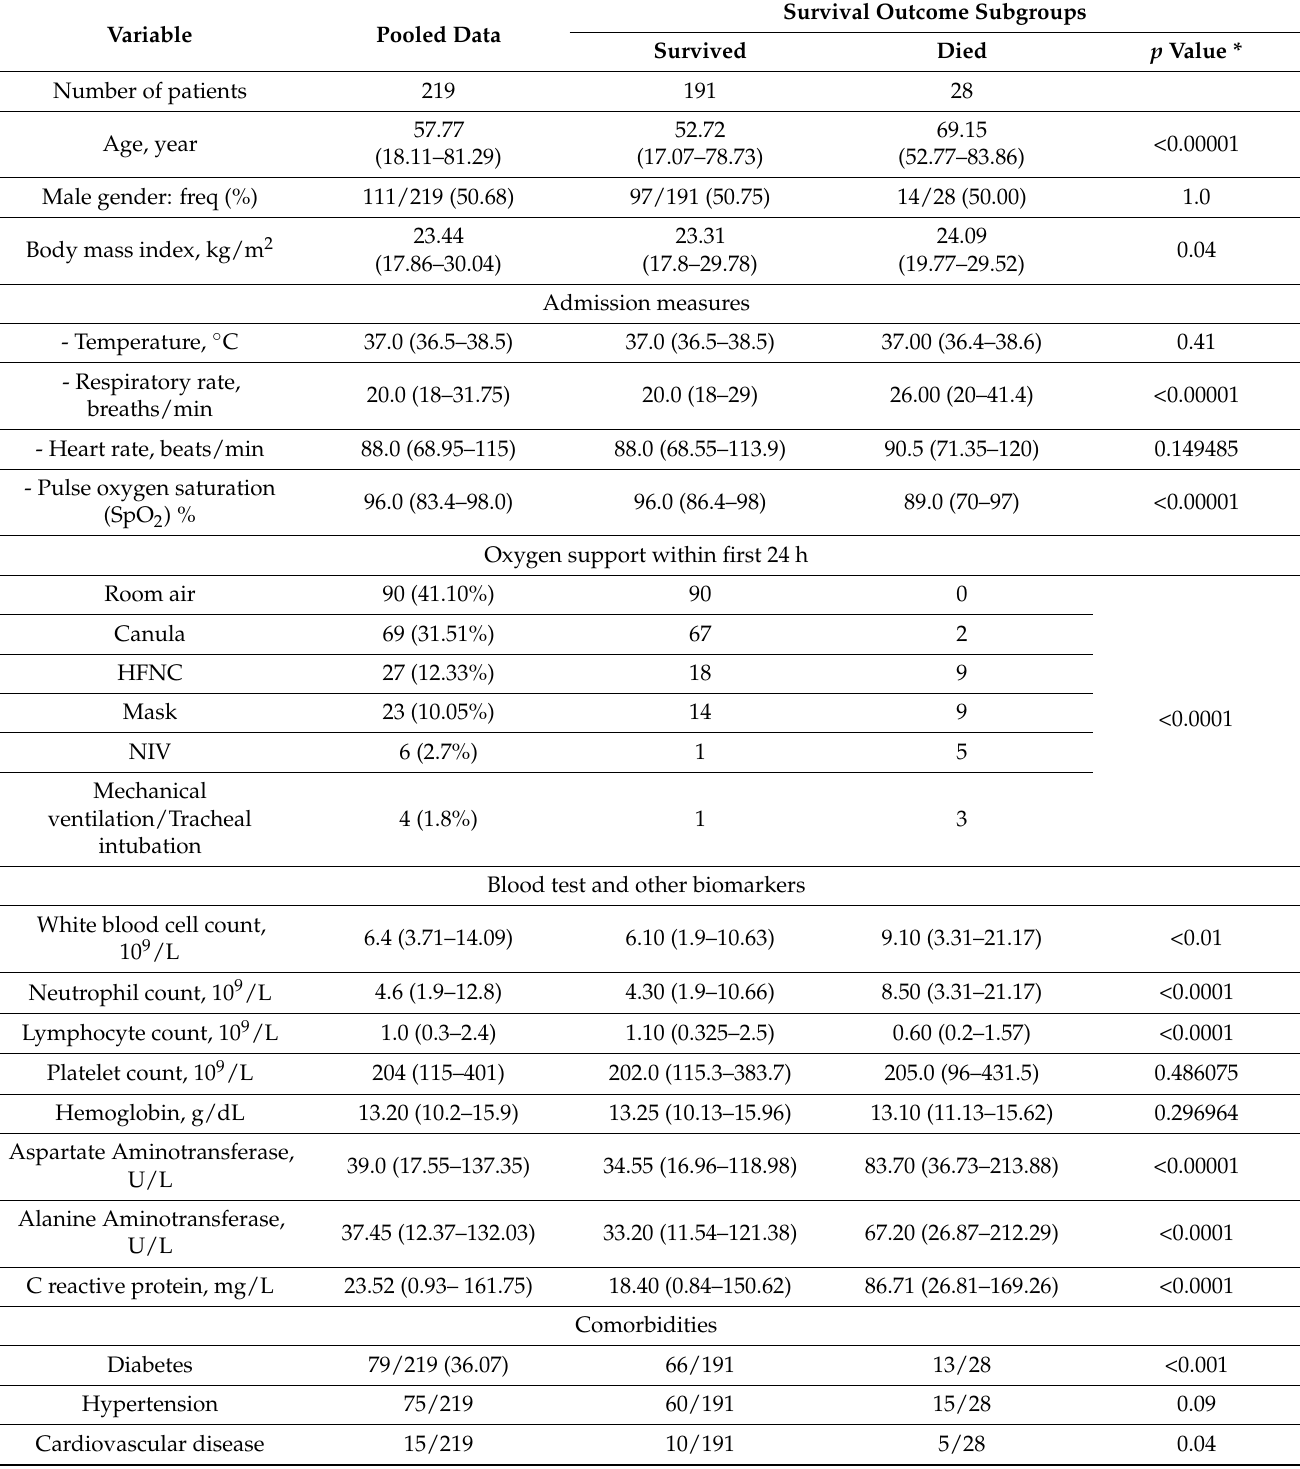
Table 1. Clinical characteristics of study